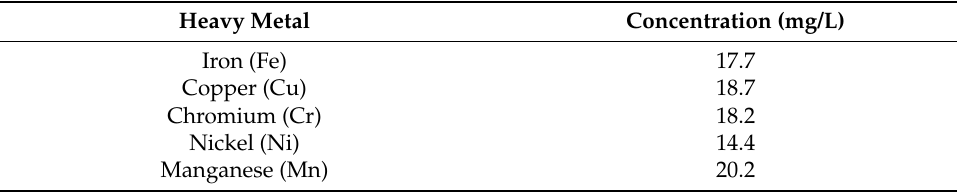
Table 1. Initial concentrations of some heavy metals in the analyzed mixed standard.